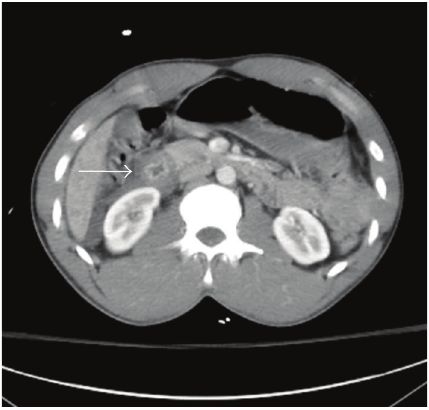
Figure 2: Discontinuity of the wall of the second portion of the duodenum is noted with surrounding intermediate attenuation fluid. Multiple foci of intra-abdominal free air are also